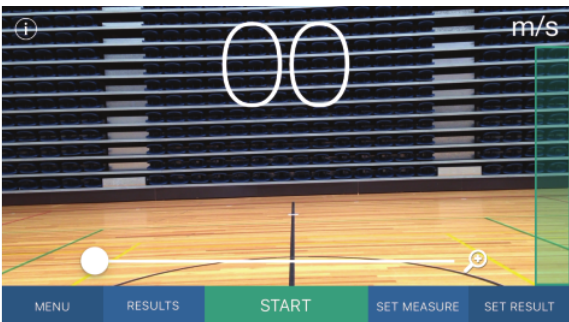
Figure 1: Screenshot of iPhone 5c showing motion detection zones at each edge of the field of